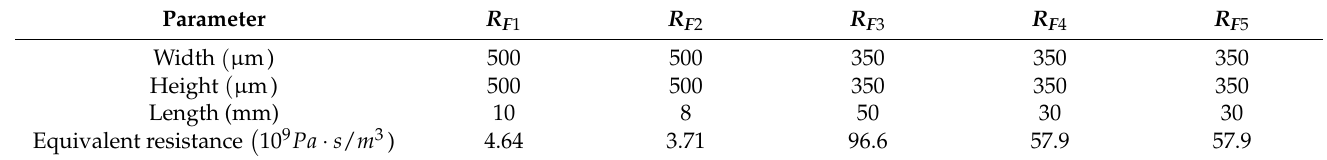
Table 1. Dimensions of the device and values of some parameters of the